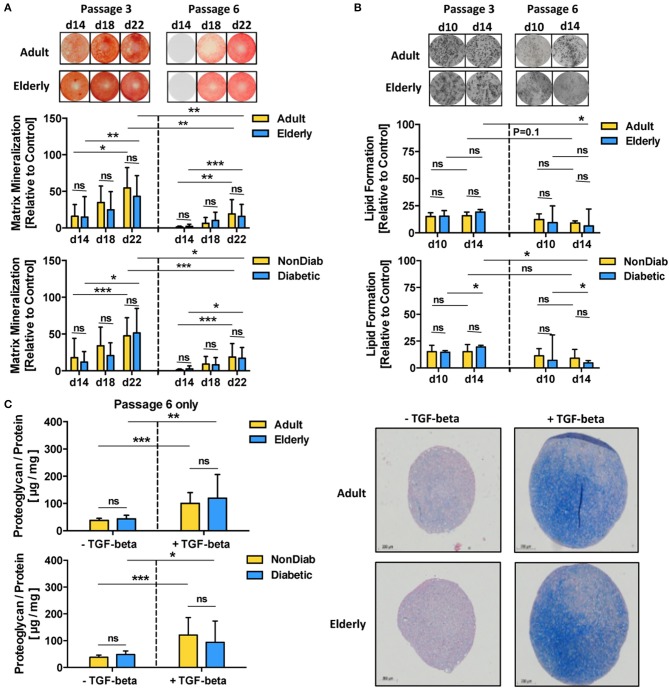
Multilineage differentiation potential of BMSCs. The differentiation capacity of MSCs from adult and elderly (n = 9 vs. 12) and non-diabetic and predominantly non-insulin-dependent early-stage diabetic donors (n = 14 vs. 7) was assessed with different in vitro assays. (A) Osteogenic differentiation was assessed by quantification of BMSC matrix mineralization upon osteogenic induction for 14, 18, and 22 days, with representative images for Alizarin red staining shown at the top. Quantification revealed a time-dependent increase in mineralization for all groups (day 14 vs. day 22) both at passages 3 and 6, while there was no difference between adult vs. elderly or non-diabetic vs. diabetic donors at either time point or passage but a strong reduction in mineralization for higher vs. lower passage cells (P6 vs. P3). (B) Adipogenic differentiation of BMSCs upon in vitro adipogenic induction for 10 and 14 days was quantified by staining of lipid-rich vacuoles with Nile Red, with representative images for vacuole formation shown at the top. Quantification revealed similar vacuole formation for both time points (day 10 vs. day 14), with a trend of modest reduction when comparing higher vs. lower passage cells (P6 vs. P3). There was again no difference between adult vs. elderly or non-diabetic vs. diabetic donors at either time point but a stronger passage-dependent reduction for cells from elderly or diabetic donor donors (P3 vs. P6), though this was less notable for cells from adult or non-diabetic donors. (C) Chondrogenic differentiation of BMSCs upon induction with TGF-beta was quantified as the ratio of proteoglycan synthesis relative to protein content, with representative histology images for alcian blue proteoglycan staining of pellet sections shown to the right. There was no difference between BMSCs from adult vs. elderly or non-diabetic vs. diabetic donors. Data are shown as mean ± SD, and statistical evaluation was performed by using a Student's t-test or ANOVA followed by post-tests (*p < 0.05, **p < 0.01, and ***p < 0.001).